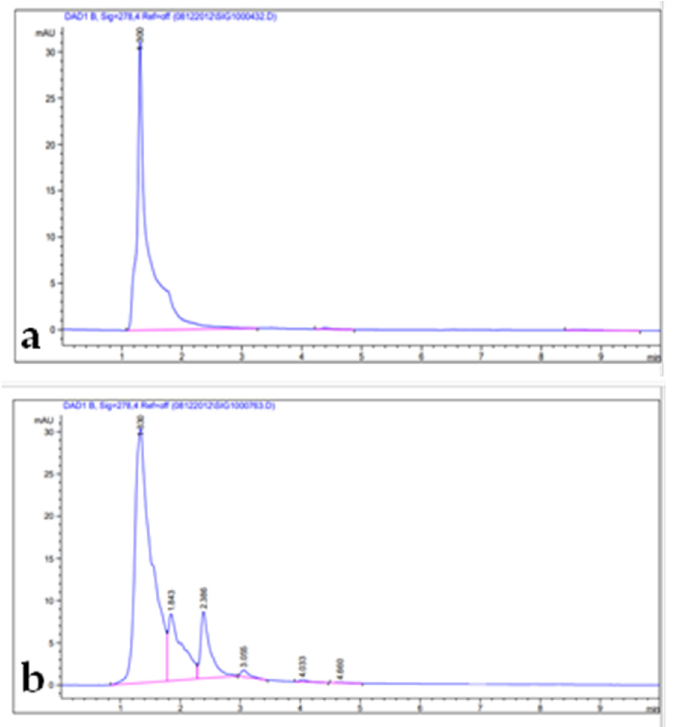
Figure 3. HPLC chromatograms: ( a ) quercetin standard; ( b ) leaf extract.